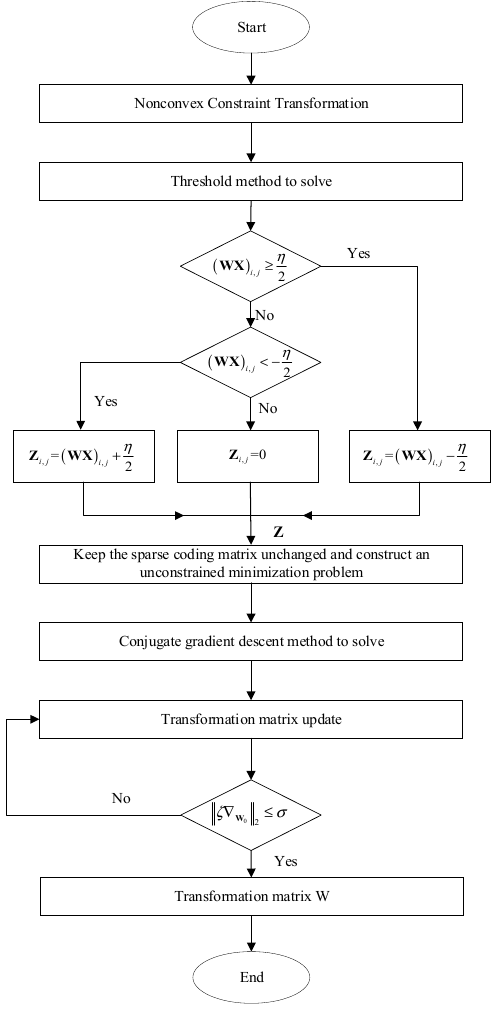
Figure 2. Flowchart of solving sparse transformation.